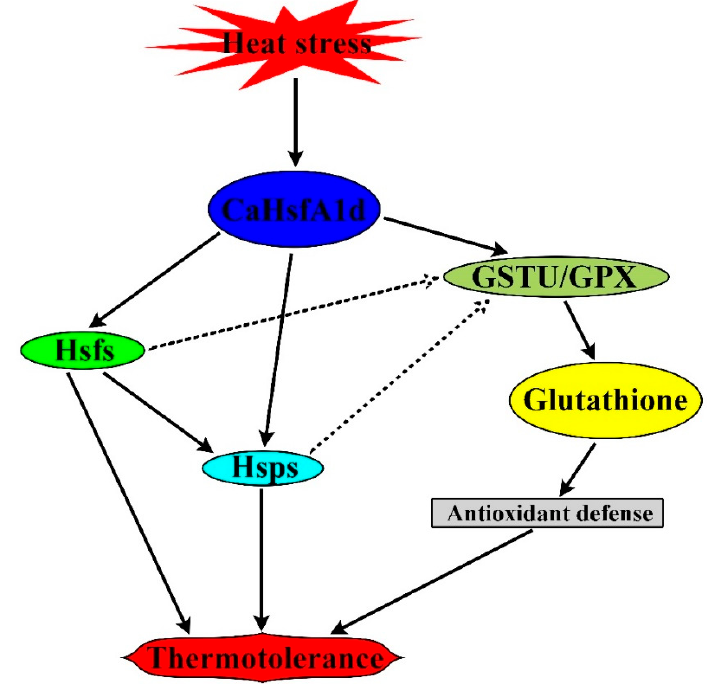
Figure 10. Working model proposed for CaHsfA1d-mediated thermotolerance in plant.